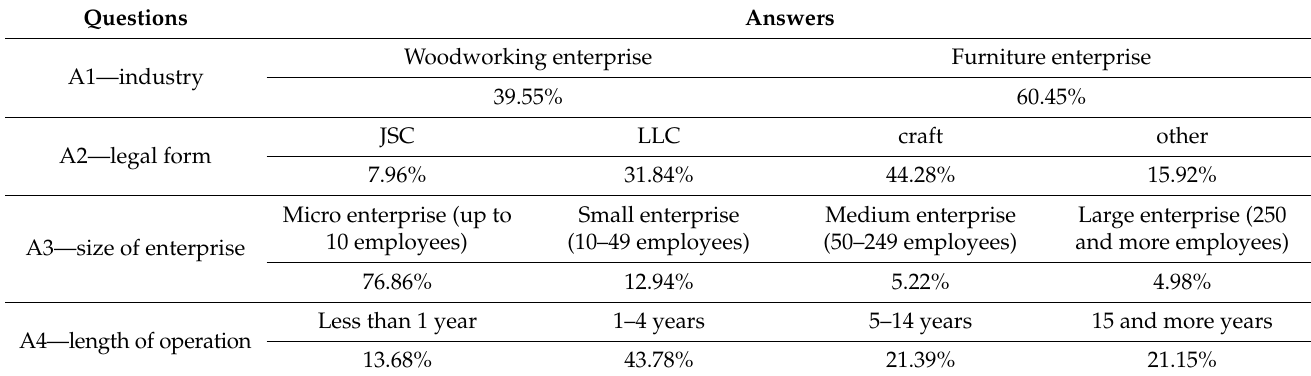
Table 1. Characteristics of woodworking and furniture enterprises (WFEs)—answers on the questions of characteristics of the enterprise